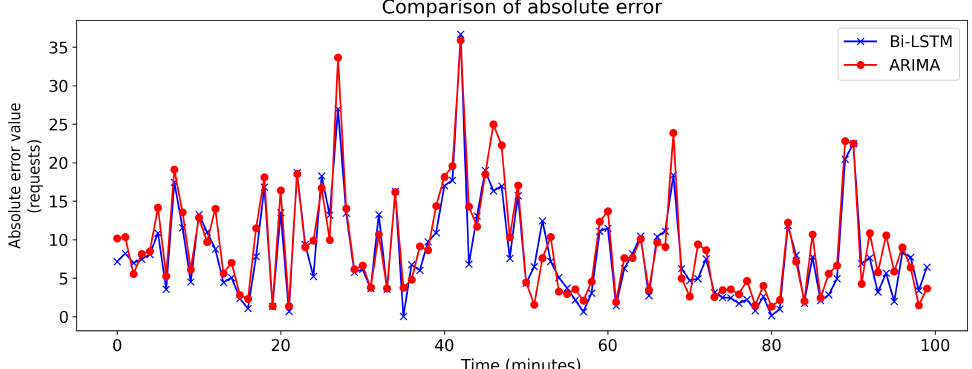
Figure 9. Comparison of absolute error for the first 100 minutes of NASA testing